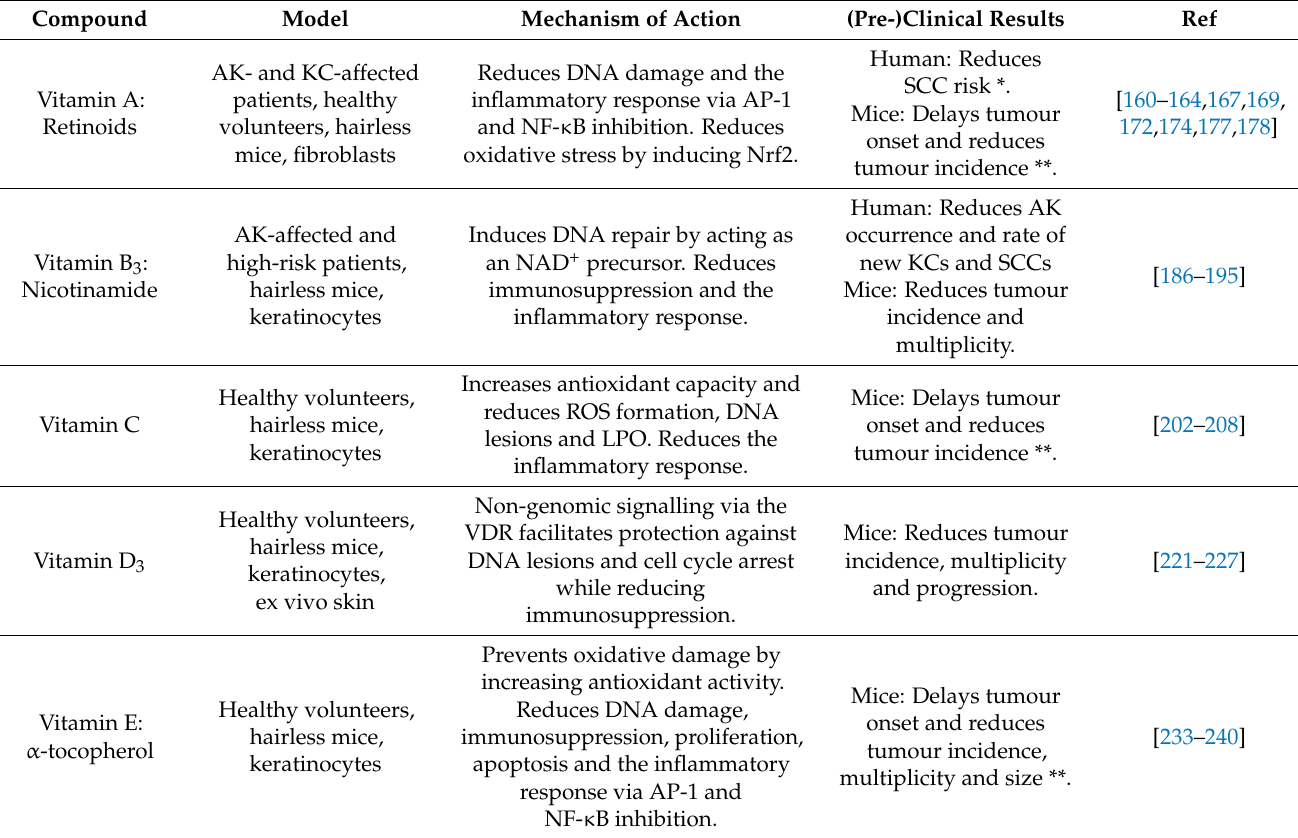
Table 4. Selected vitamins and derivates that have been tested for photoprotective effects, their proposed mechanisms and, if applicable, (pre-)clinical